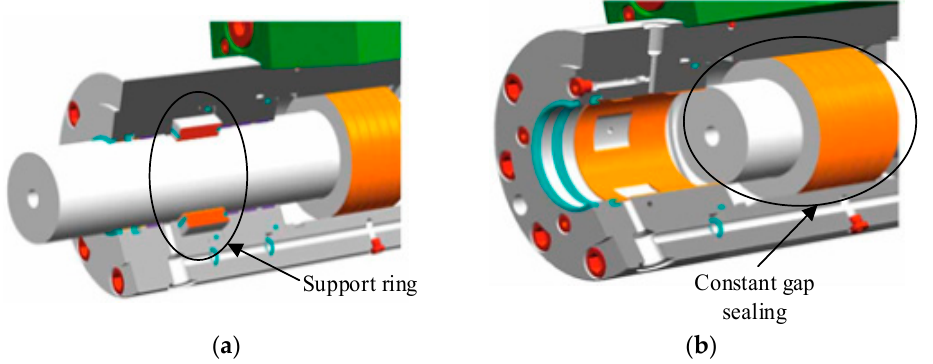
Figure 5. Schematic diagram of the constant gap sealing: ( a ) support ring of constant gap sealing;